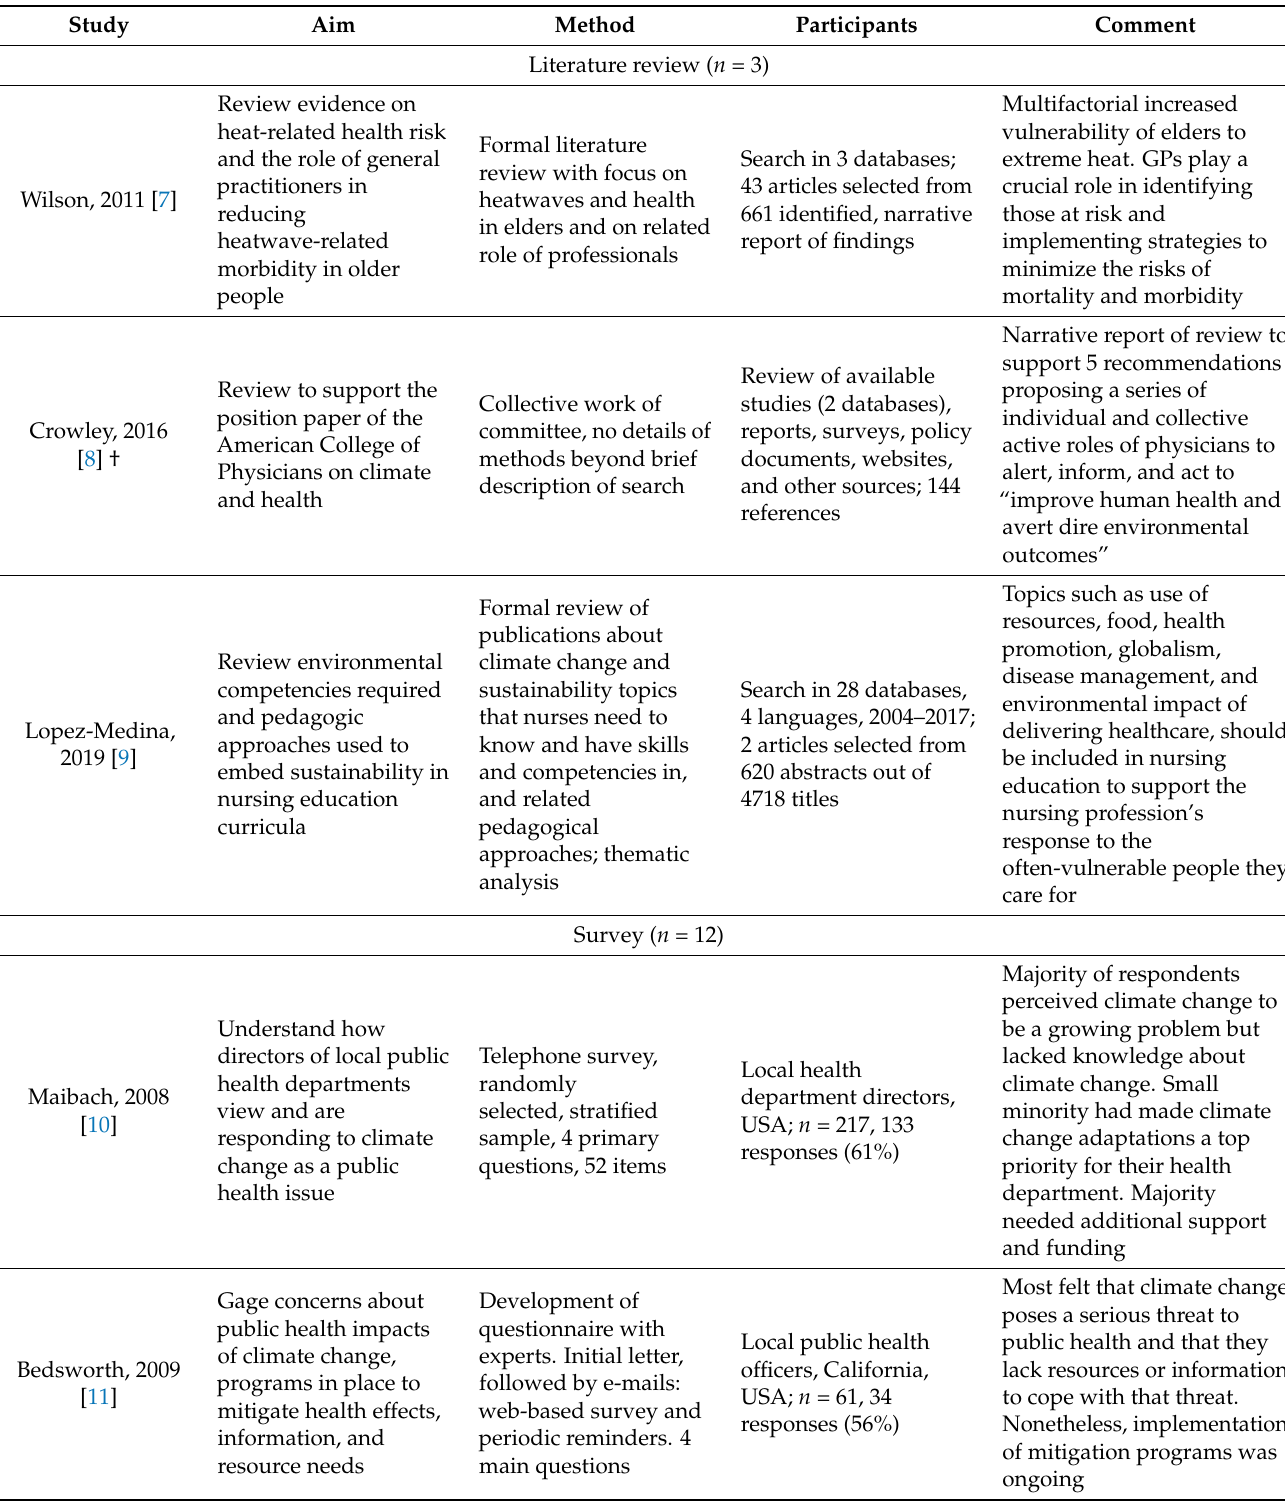
Table 2. Description of 22 studies; reports of elements from published documents